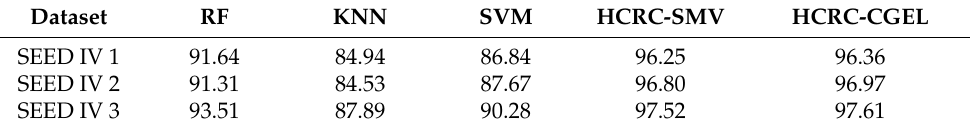
Figure 8. Results of each method on SEED IV database. Table 4. Performance (%) of different methods in the three sessions of SEED IV database.